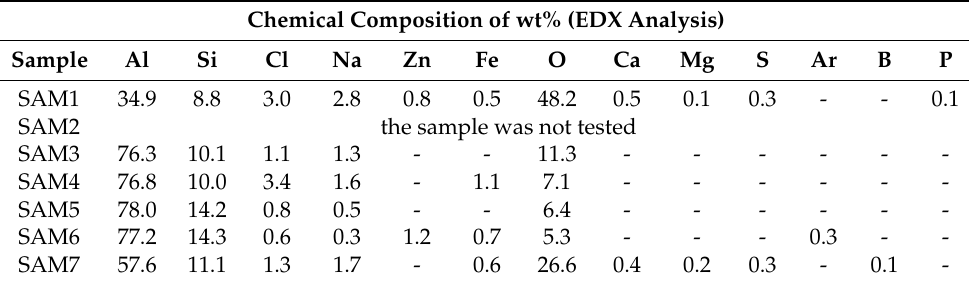
Table 7. Local chemical composition of AlSi12 alloy according to EDX analysis.